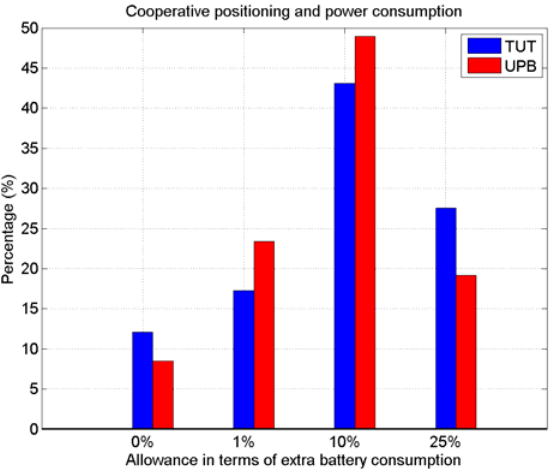
Figure 11. Allowance for extra battery consumption in the context of cooperative